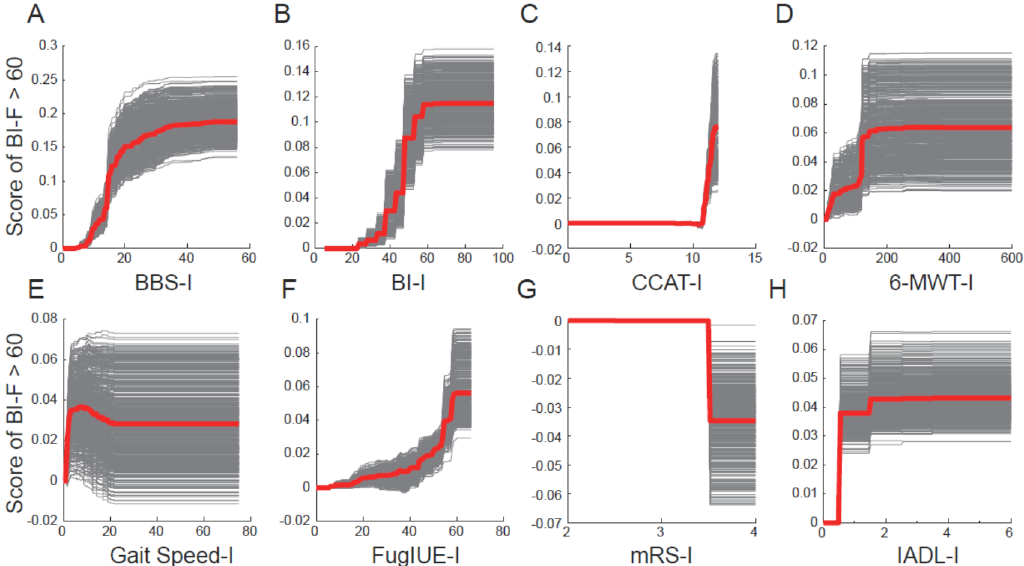
Figure 3. Partial dependence plot (PDP) and individual conditional expectation (ICE) plot. ( A – H ) BI-F > 60 as a function of BBS-I ( A ), BI-I ( B ), CCAT-I ( C ), 6-MWT-I ( D ), Gait Speed-I ( E ), FuglUE-I ( F ), mRS-I ( G ), and IADL-I ( H ). Gray lines represent the functional relationship between the score of BI-F > 60 and the predictors, and the red line represents the PDP and the mean of the ICE lines. A BI-F score of >60 is affected by the value of the above-mentioned parameters. The “-I” and “-F” represent the initial and final functional assessments at the PAC-CVD hospital. PAC-CVD: Post-Acute Care-Cerebrovascular Disease; BBS: Berg Balance Test; BI: Barthel Index; CCAT: Concise Chinese Aphasia Test; 6-MWT: 6-Minute Walk Test; FuglUE: Fugl–Meyer Upper Extremity Assessment; mRS: modified Rankin Scale; IADL: Lawton–Brody Instrumental Activities of Daily Living Scale.